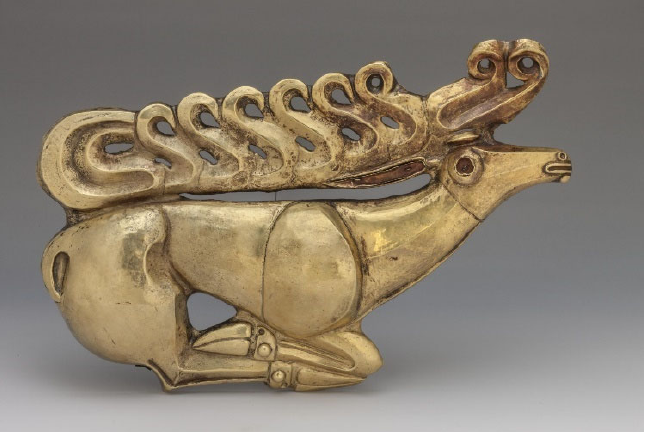
Figure 3. Shield plaque in the form of a deer (SHM inv. no. 2498 ‐ 1); embossed and chased gold; Kurgan 1, Kostromskaya, Kuban region, Russia; second half of the 7th century BC. [Image is used from